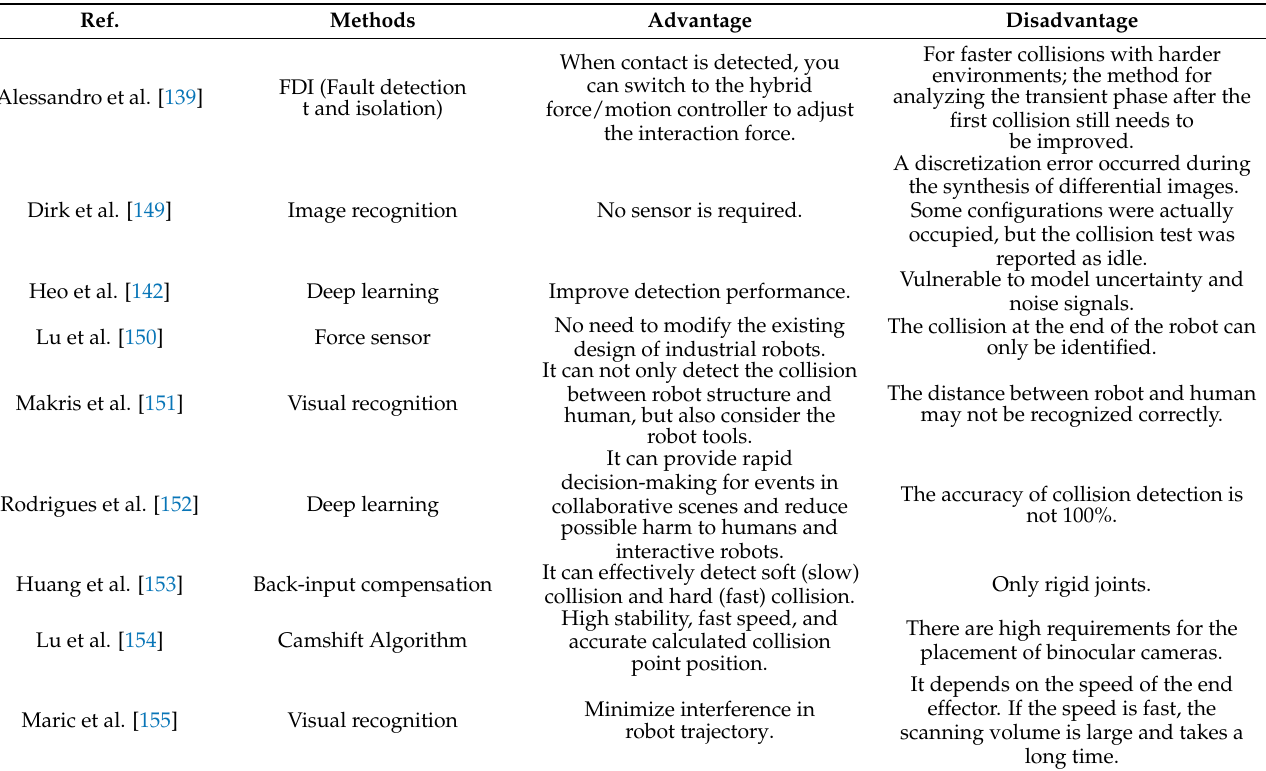
Table 9. Related detection methods and their application advantages and